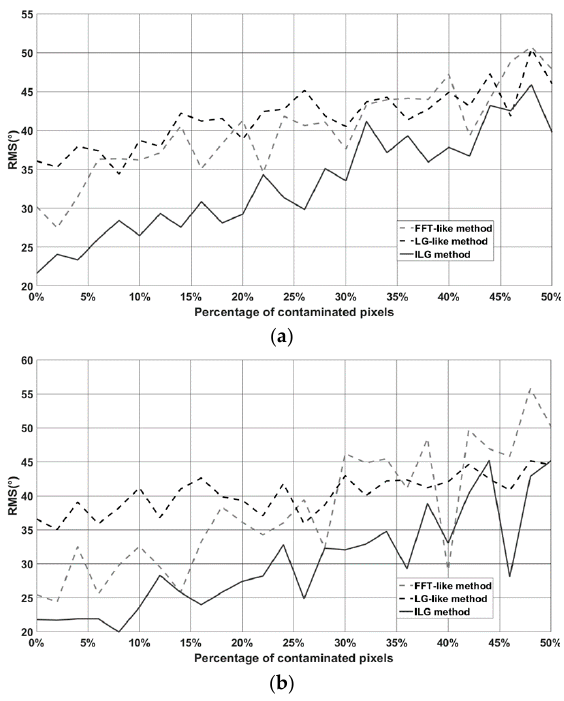
Figure 12. Root-mean-square (RMS) differences between the retrieved results of each method and the interpolating wind directions when the salt-and-pepper noise exists with different intensity: ( a ) ECMWF and ( b ) CCMP.